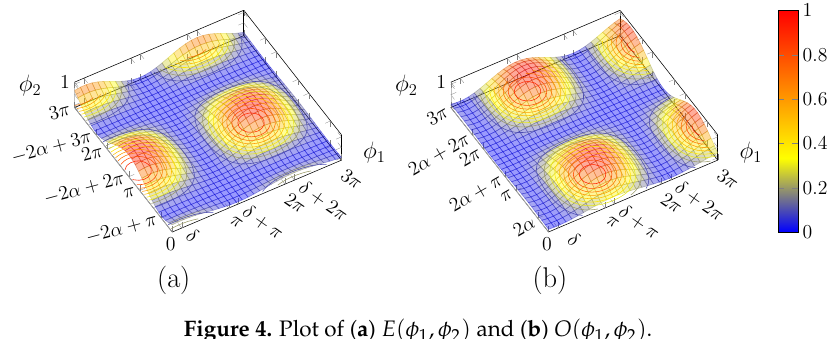
Figure 4. Plot of ( a ) E ( φ 1 , φ 2 ) and ( b ) O ( φ 1 , φ 2 ) .